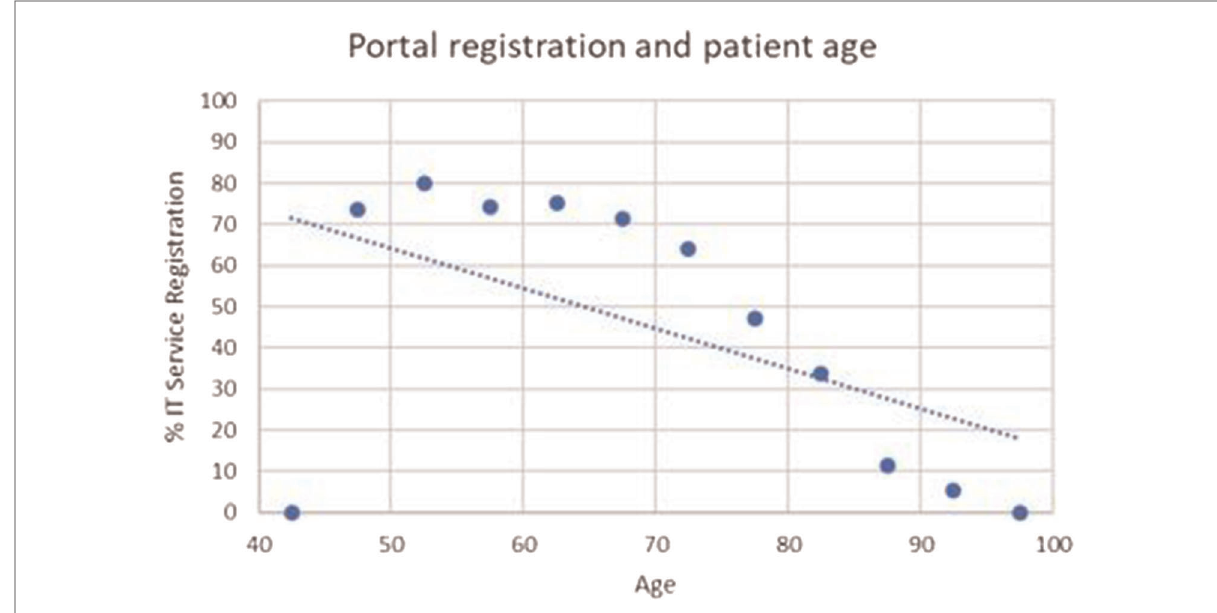
FIGURE 2 Portal registration by age.